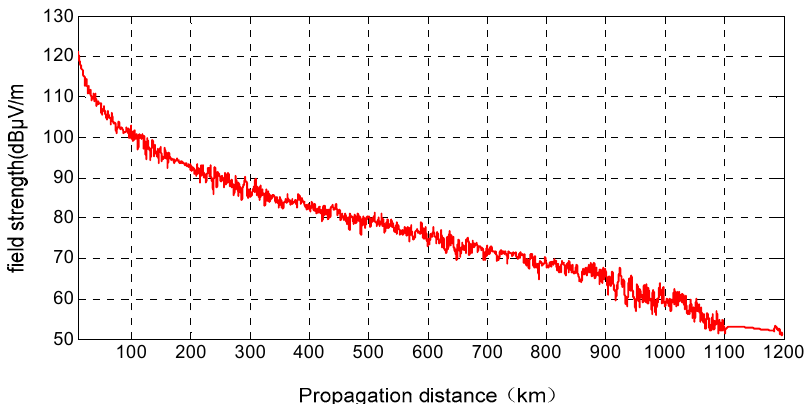
Figure 12. Field intensity propagation curve for the transmitted signal from the eastward-oriented antenna.